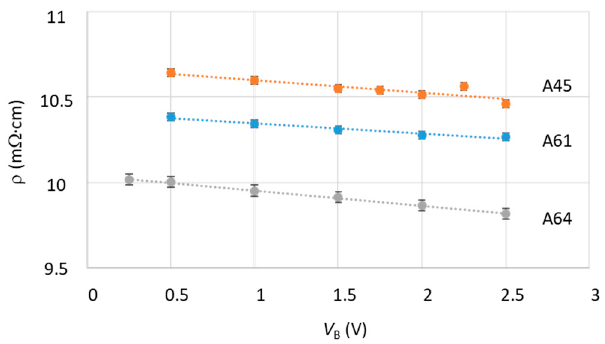
Figure A2. Resistivity ρ (m Ω · cm) versus bias voltage V B (V) for samples A45, A61 and A64.